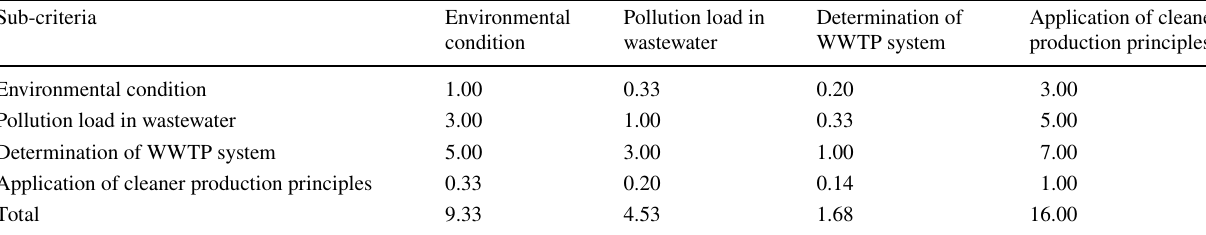
Table 5 Matrix comparison of sub-criteria Sub-criteria